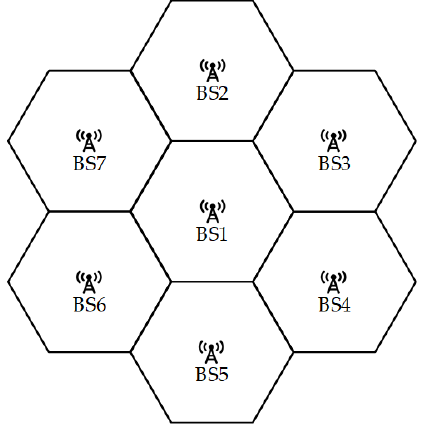
Figure 2. CNFS network topology .